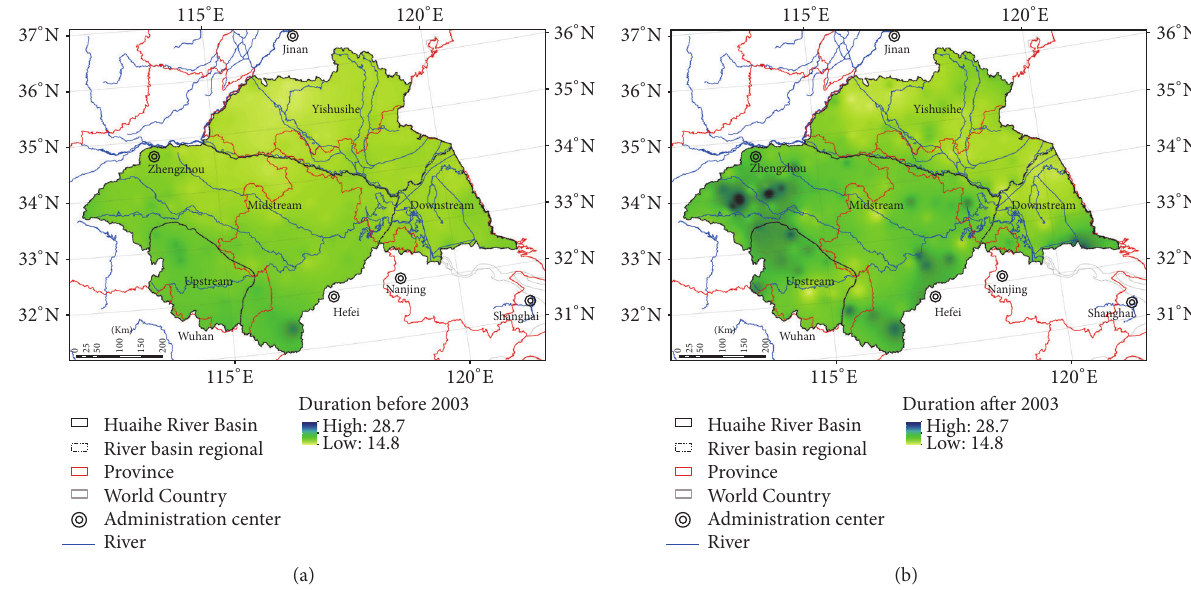
Figure 14: Spatial distribution of isolated rainstorm event duration, before and after mutation time.